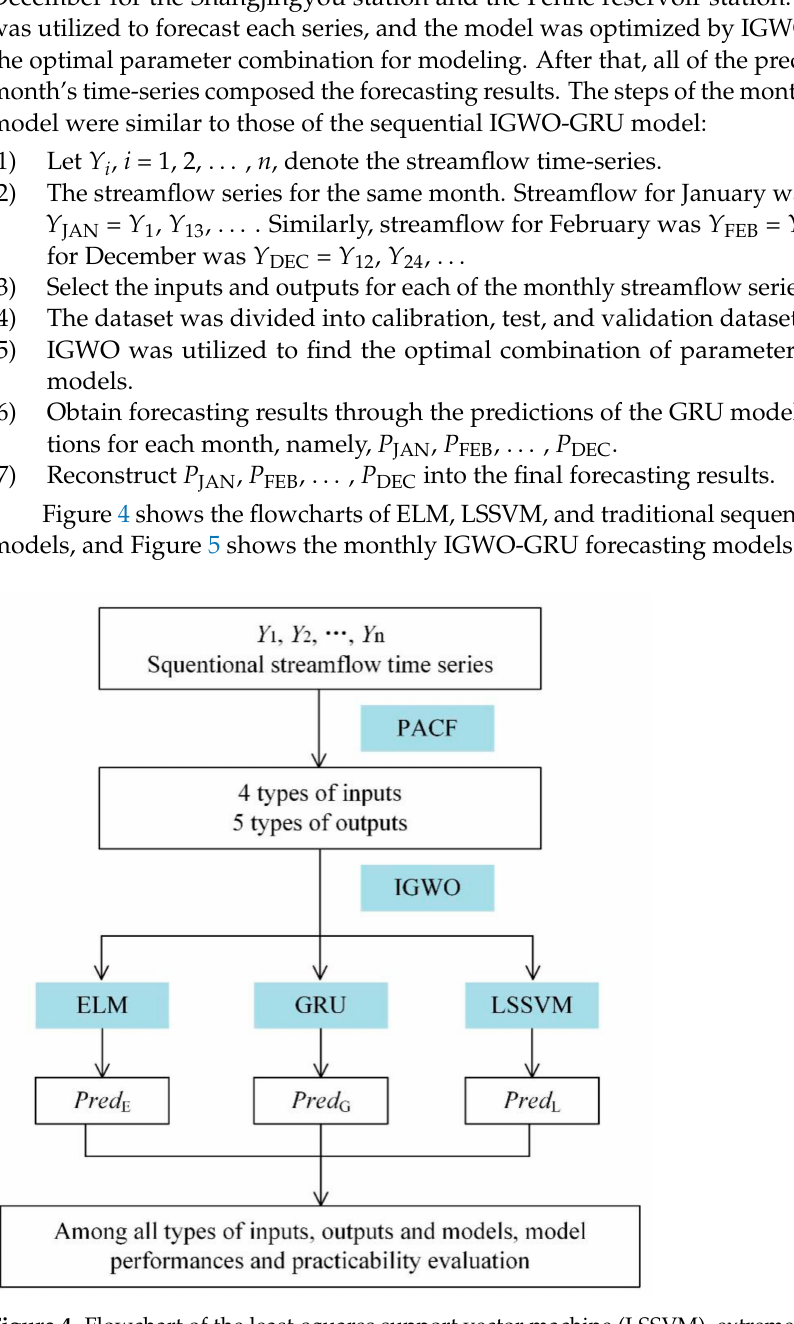
Figure 4. Flowchart of the least-squares support vector machine (LSSVM), extreme learning machine (ELM), and sequential IGWO-GRU